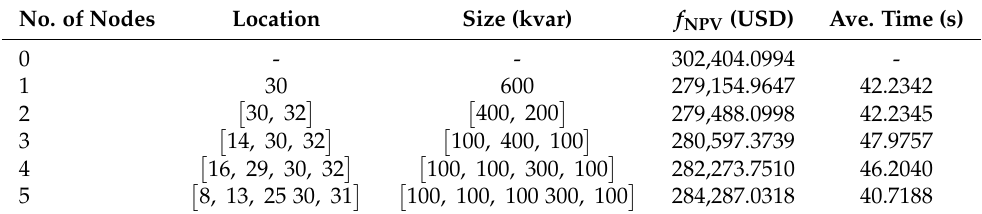
Table 4. Numerical results for the IEEE 33-bus grid with meshed